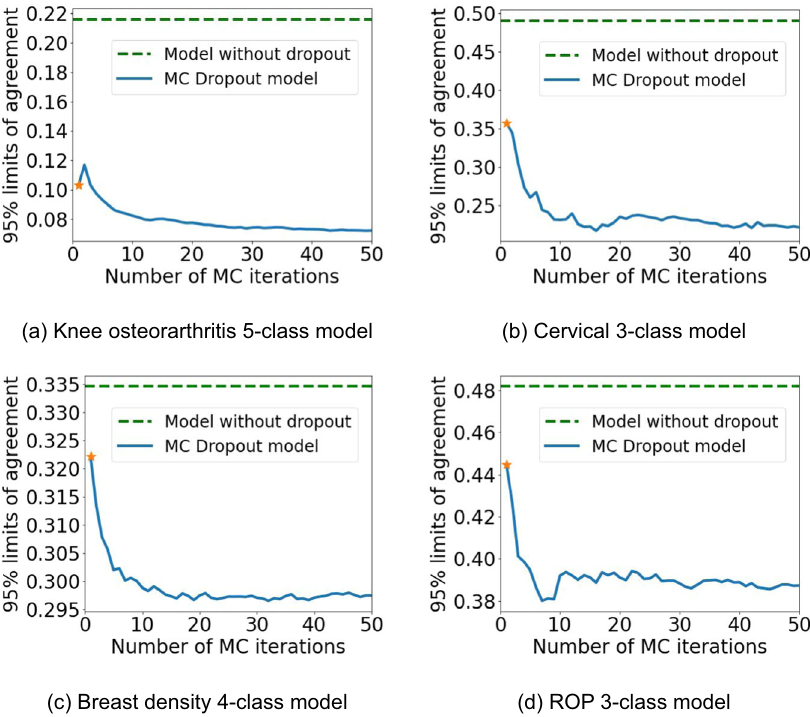
Fig. 4 Impact of number of MC iterations on repeatability. ( a ) Knee osteoarthritis 5-class model. ( b ) Cervical 3-class model. ( c ) Breast density 4-class model. ( d ) ROP 3-class model. The orange star represents a single forward pass of the model with dropout disabled at test